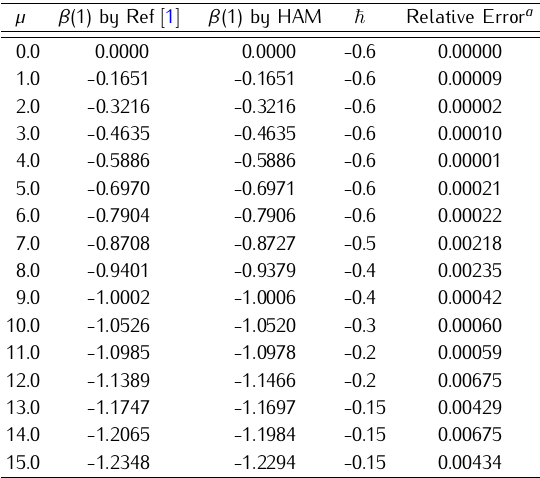
Table 2. Comparison of the HAM solution and numerical solution by Liabai and Simmonds [1] for tip deflection of a heavy elas- tica (L = 1).